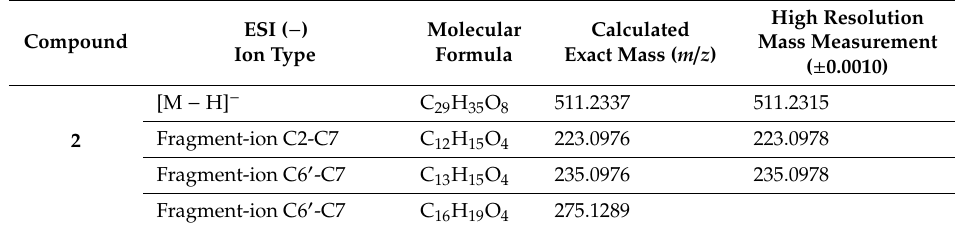
Table 5. High resolution MS data for parent and daughter ions of acylphloroglucinols 2 – 6 as measured by